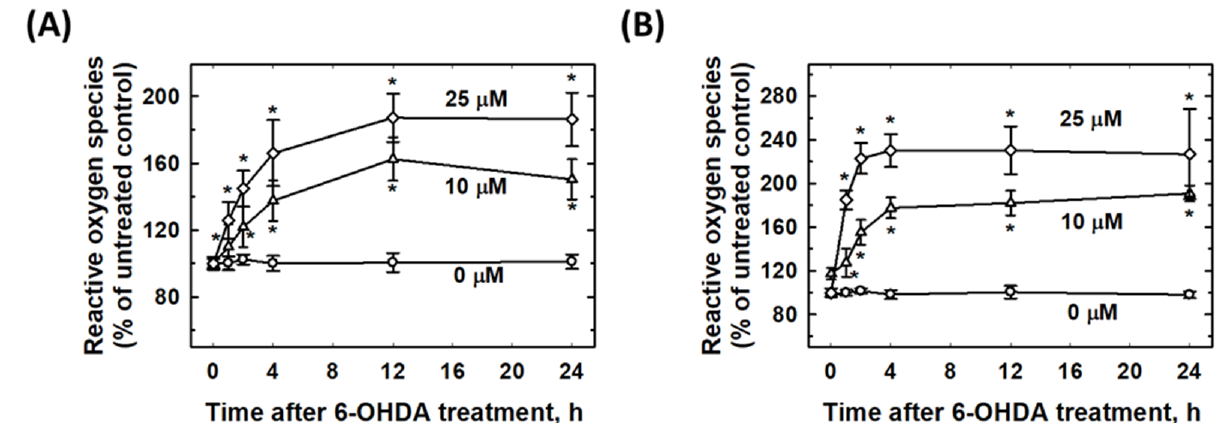
Figure 6. 6-OHDA induced the elevation of reactive oxygen species (ROS) in dose-dependent manner in SH-SY5Y and SK-N-SH cells. ( A ) Induction of 6-OHDA expression in SH-SY5Y intracellular ROS. ( B ) Induction of 6-OHDA on SK-N-SH intracellular ROS. * Statistically significant compared with the untreated group. Each experiment was repeated at least six times.